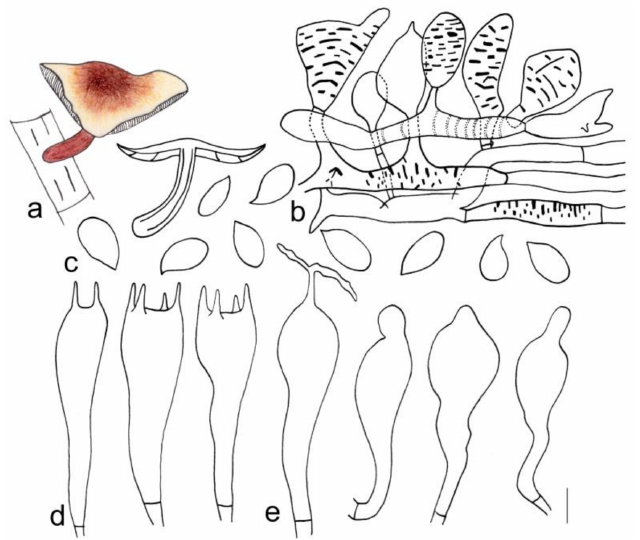
Figure 11. Morphological characteristics of Gymnopus globulosus (HMJAU 60307,